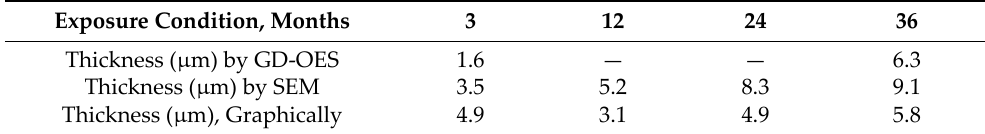
Table 4. Variations of copper oxide thicknesses on the exposed metal